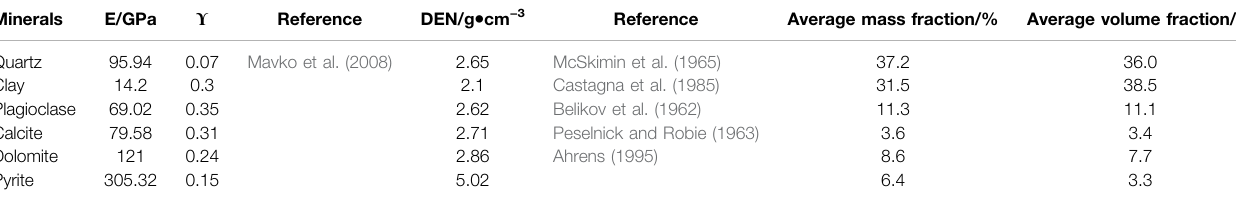
TABLE 2 | Summary of elastic parameters of common minerals in shale. Minerals